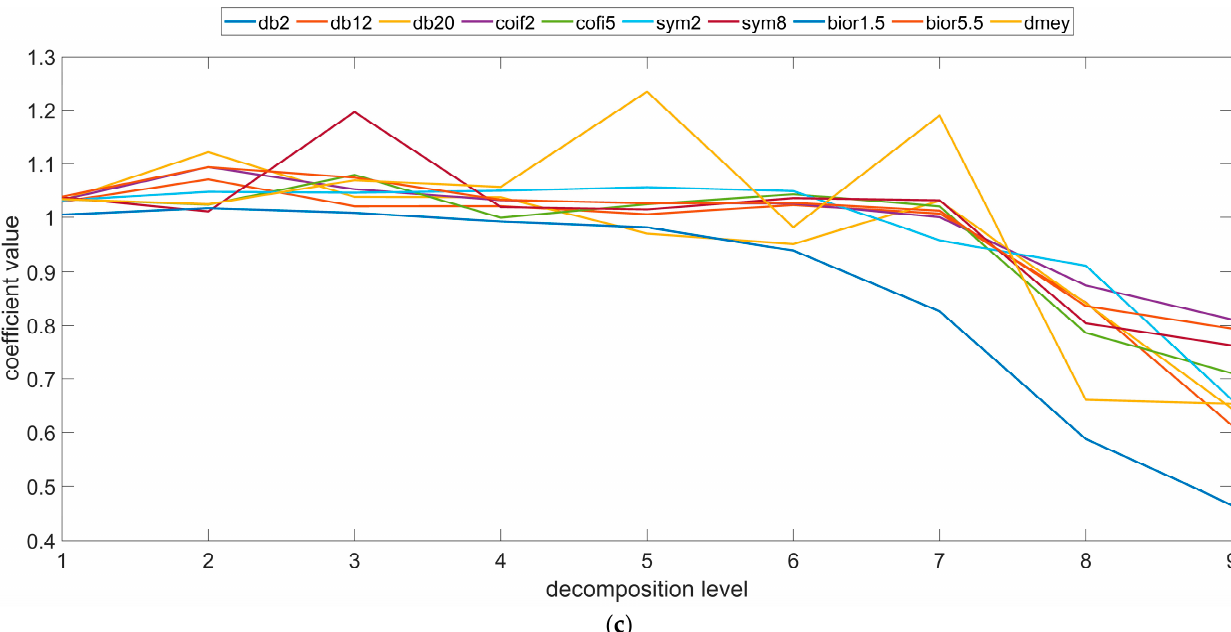
Figure 3. Coefficient value of the quotient calculated for the parameter Root Mean Square Height ( a ) 0°, ( b ) 45°, and( c ) 90°.